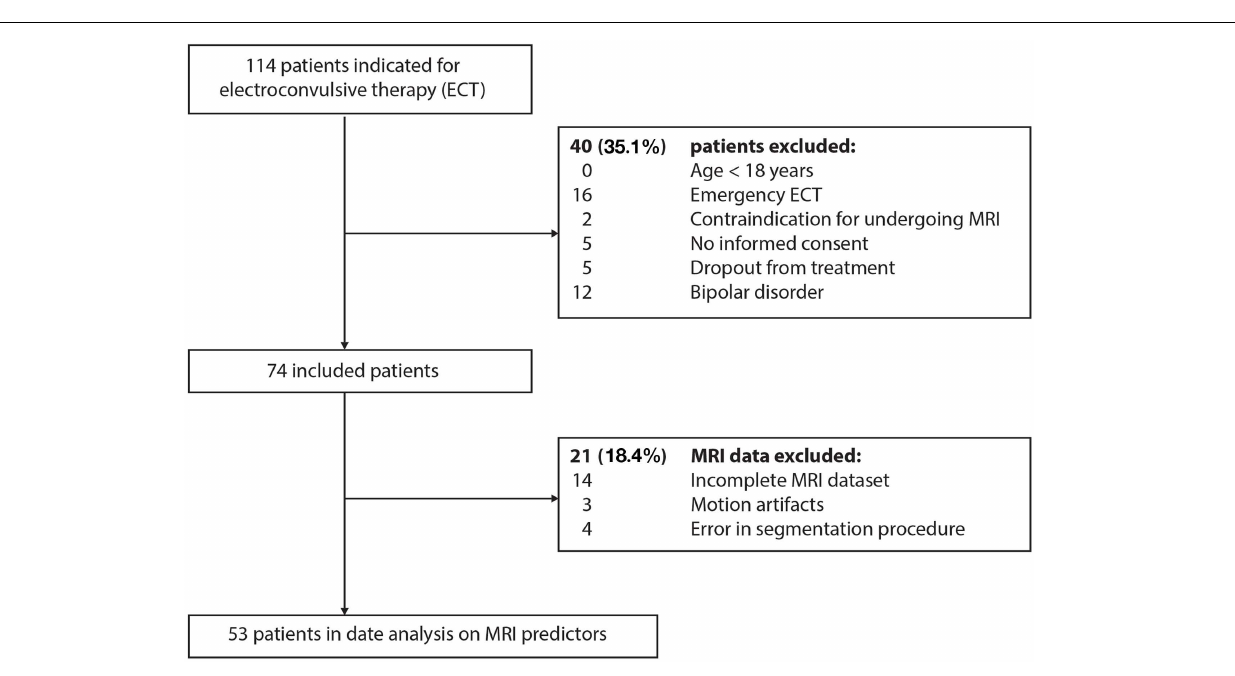
FIGURE 1 | Flow chart of the patient selection process